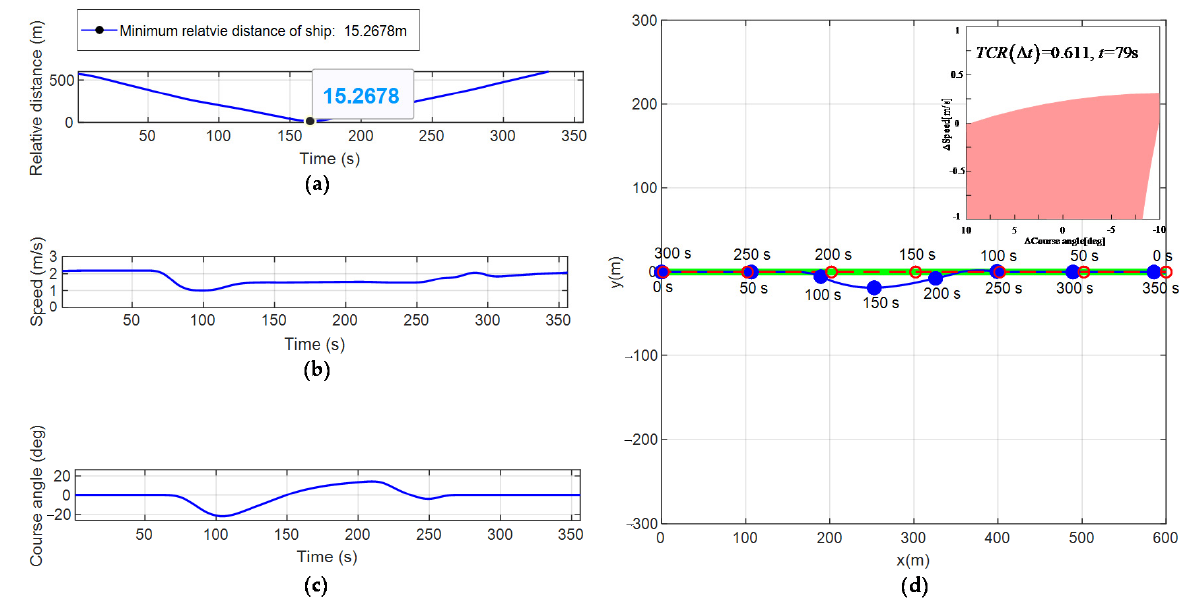
Table 6. Critical moment collision threat degree assessment results.